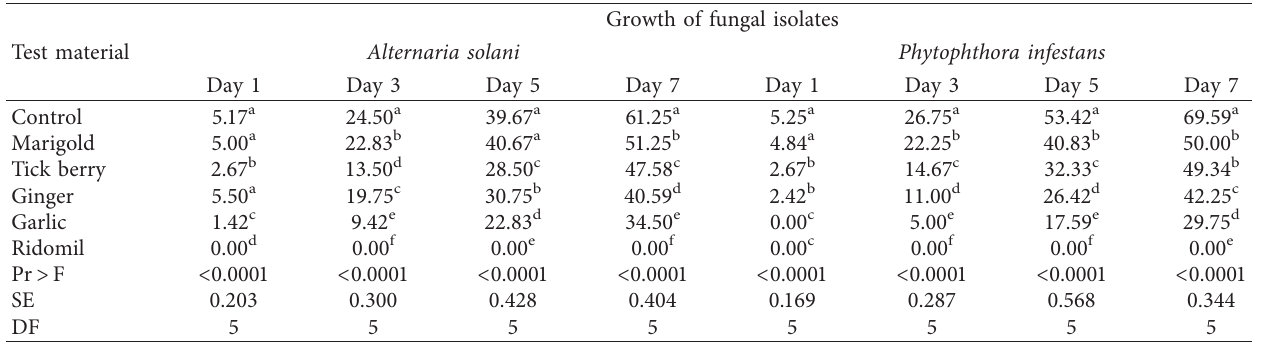
Table 3: Antimicrobial activity of ethanol-extracted plant extracts on the growth of the fungal pathogens. Test material